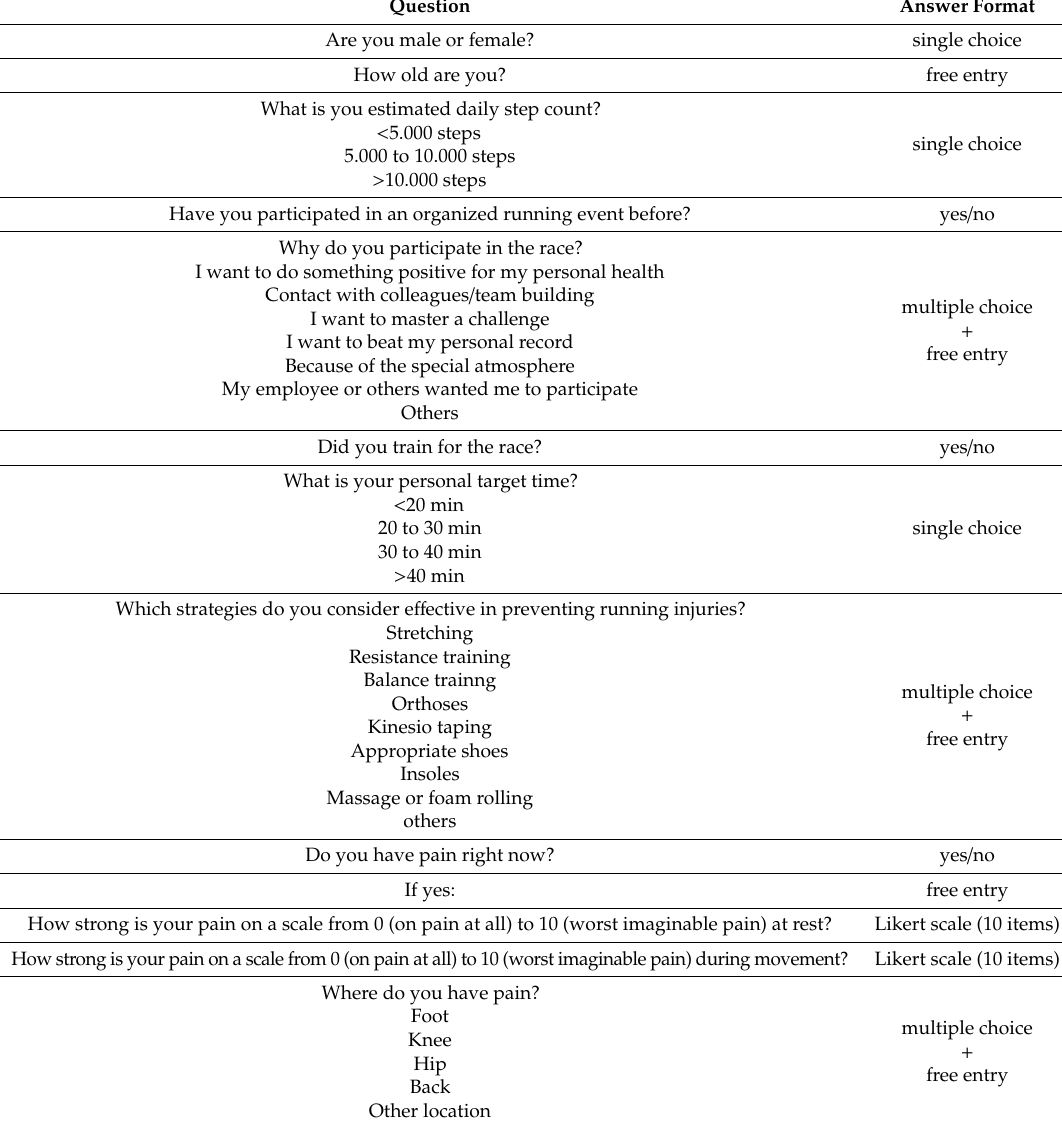
Table 1. Contents of the questionnaire administered to the event